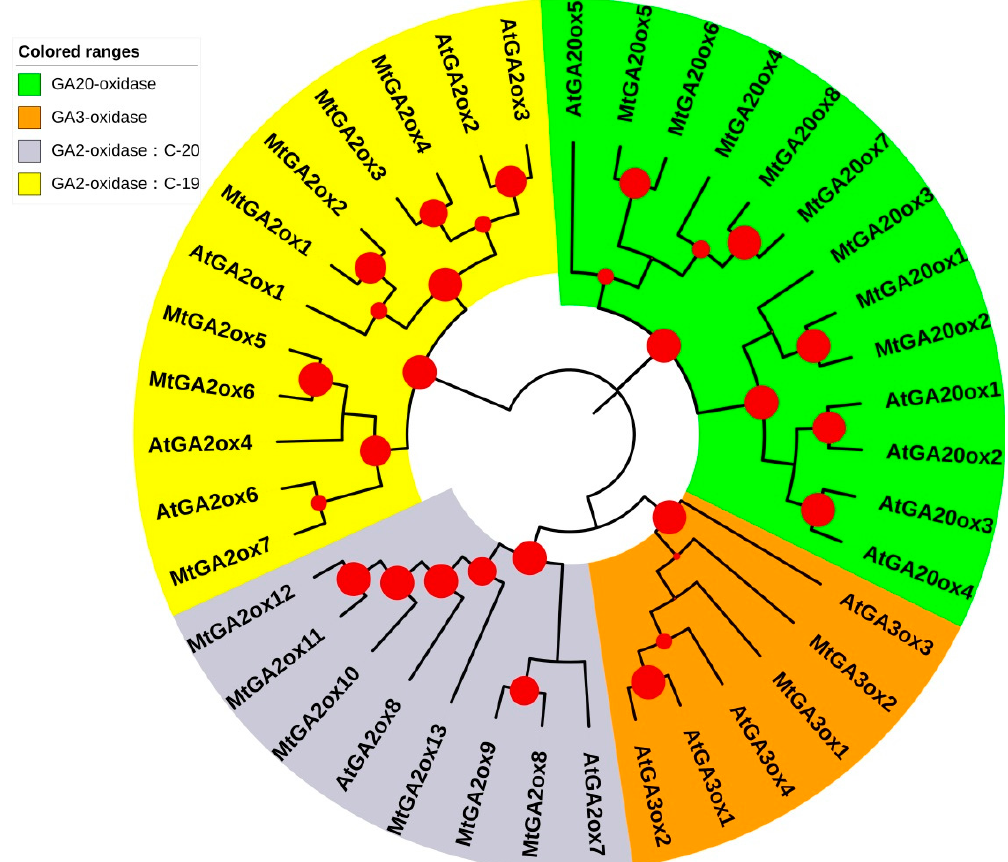
Figure 1. Phylogenetic analysis of GA20oxs, GA3oxs, and GA2oxs in A. thaliana (At) and M.truncatula (Mt). The proteins are grouped into four distinct groups. The phylogenetic tree was constructed using 39 protein sequences from A. thaliana (16) and M.truncatula (23) on iTOLv5 (Interactive Tree of Life; https://itol.embl.de/) online website. The red dots of different sizes (Min size: 5 px; Max size: 30 px) represent the bootstrap values, ranging from 0.5 to 1. The branches covered by different color represent the four group proteins.